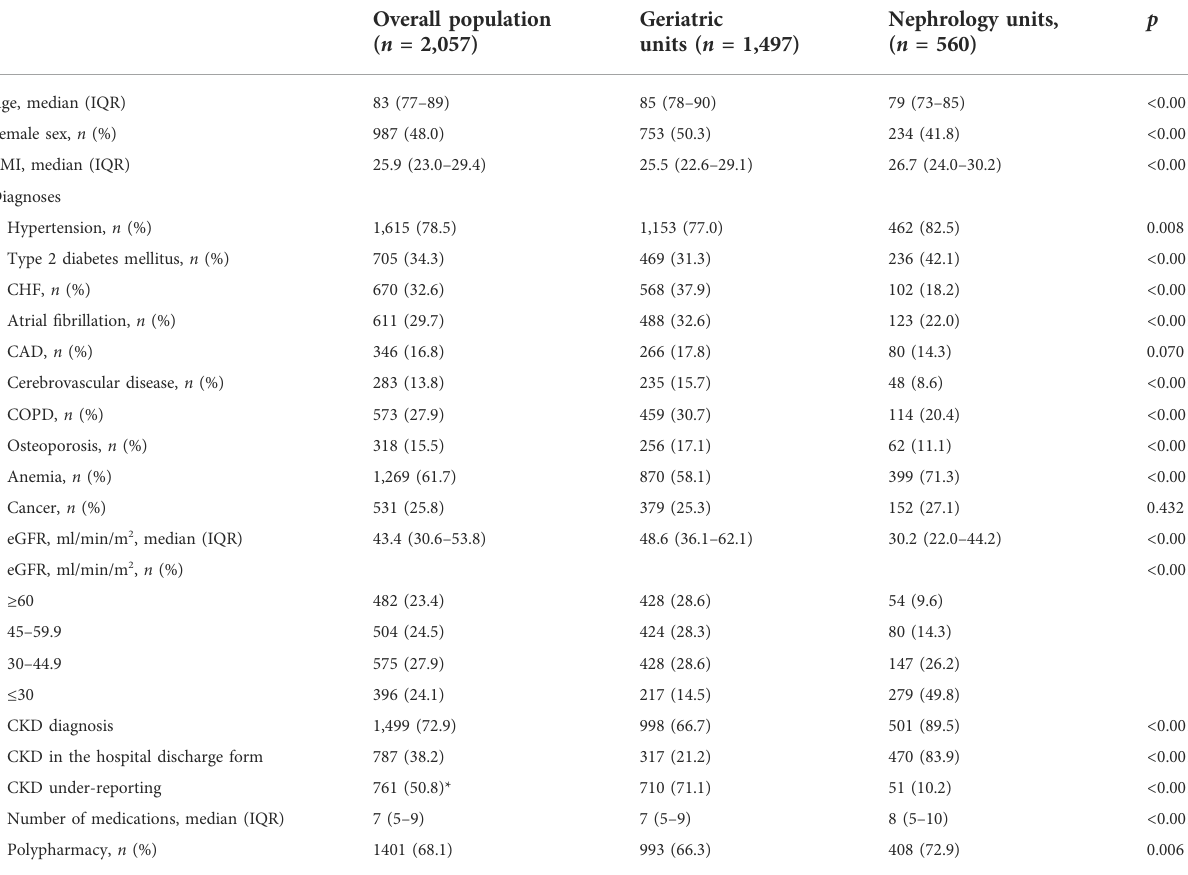
TABLE 1 Descriptive characteristics of the study population in general and strati fi ed by the type of